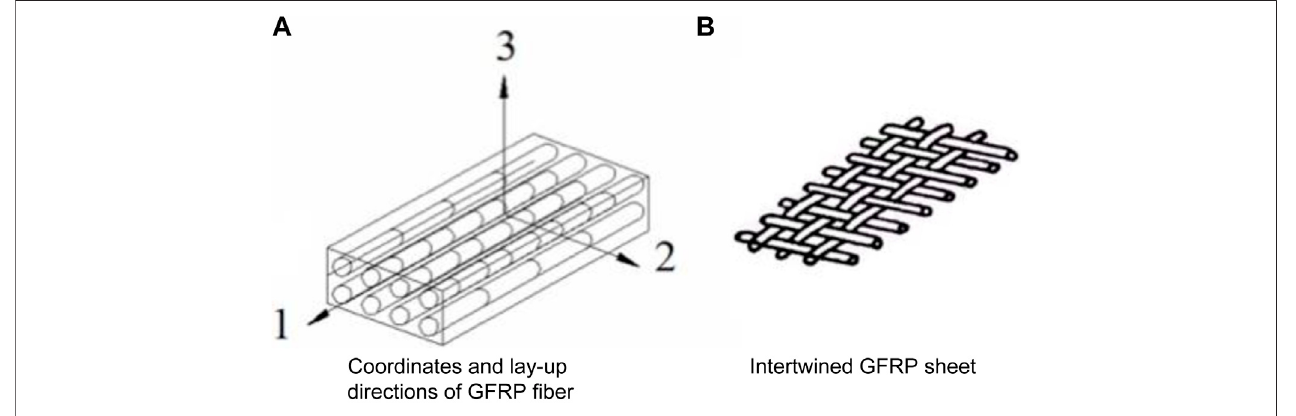
FIGURE 1 | Fiber lay-up directions of pultruded GFRP laminates. (A) Coordinates and lay-up directions of GFRP fi ber (B) Intertwined GFRP sheet.